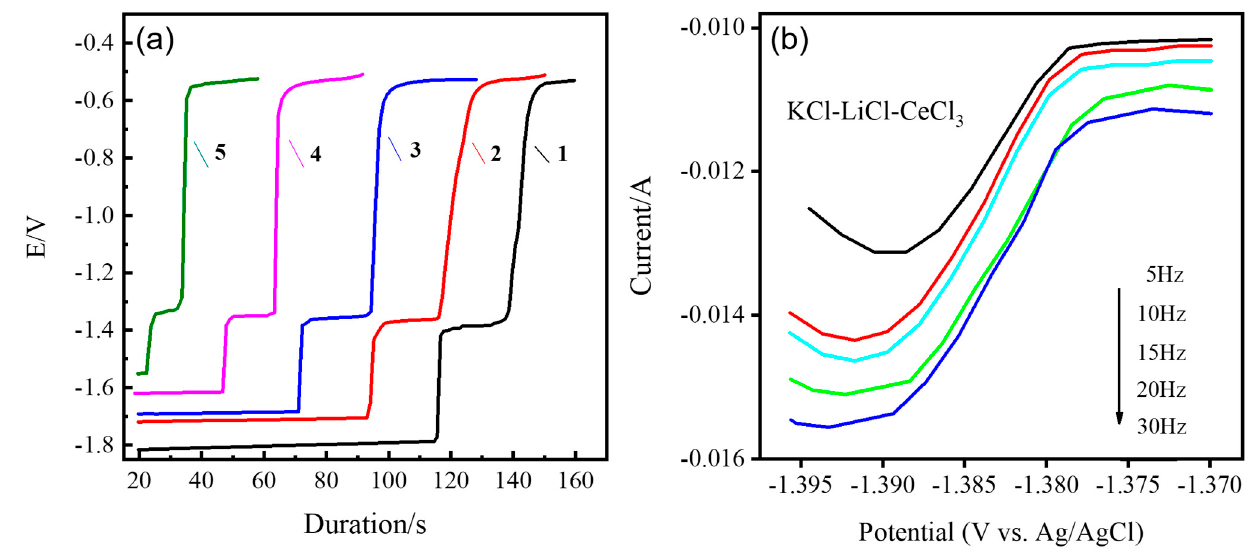
Figure 5. ( a ) Potential energy (vs. Ag/AgCl) versus time in 3LiCl-2KCl-CeCl 3 melts at different tem- peratures on liquid metal indium electrodes after short-time polarization under inert atmosphere conditions. Current—80 mA; Temperature: 1—723 K; 2—753 K; 3—773 K; 4—803 K; 5—823 K. ( b ) SWV curves of Ce 3+ on liquid metal indium electrode.